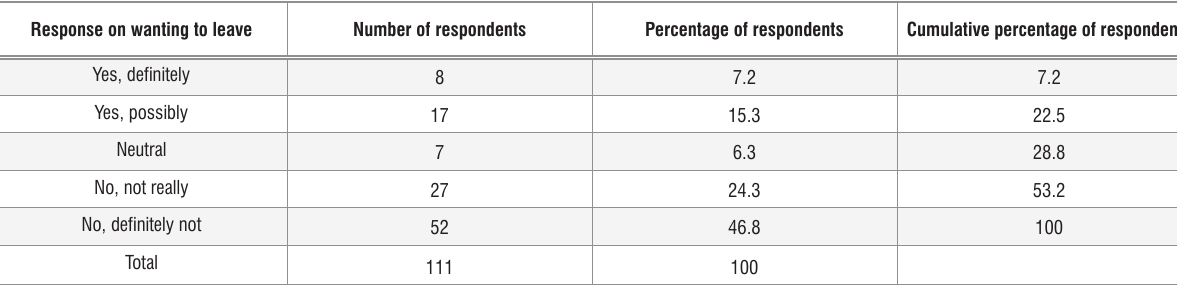
Respondents’ feelings toward leaving the Working for Water Programme